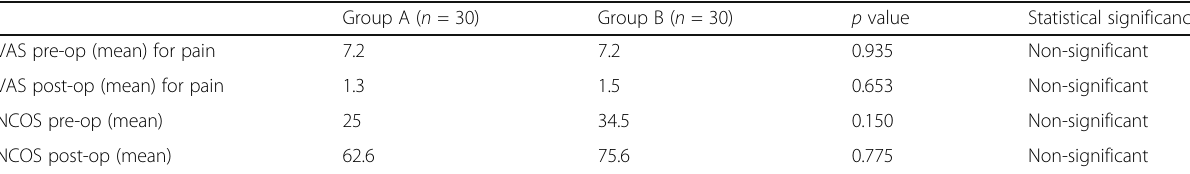
Table 1 Summary of patient ’ s data